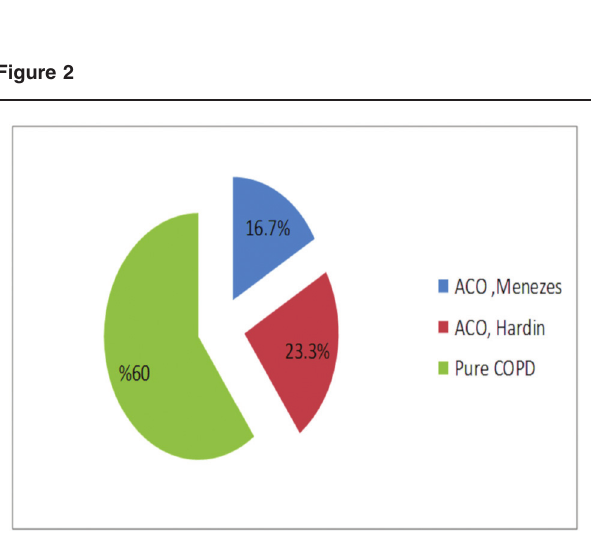
The frequency of ACO in our study by separately using Hardin or Menezes criteria. ACO, asthma-chronic obstructive pulmonary dis- ease overlap.